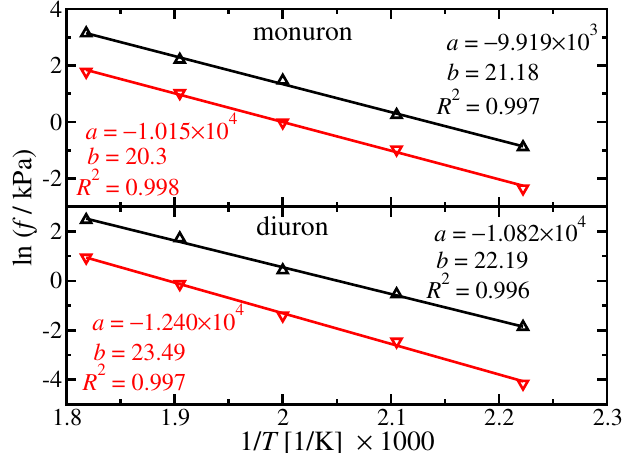
Figure 2. Pure liquid fugacity of monuron and diuron. Symbols are the pure liquid fugacity computed using molecular simulation and the solid line is the Clausius-Clapeyron fit. Triangles up and black correspond to results using SM8/CM4 partial atomic charges, and triangles down and red correspond to results using SMD/RESP. The Clausius-Clapeyron parameters and corresponding coefficient of determination ( R 2 ) is provided for each